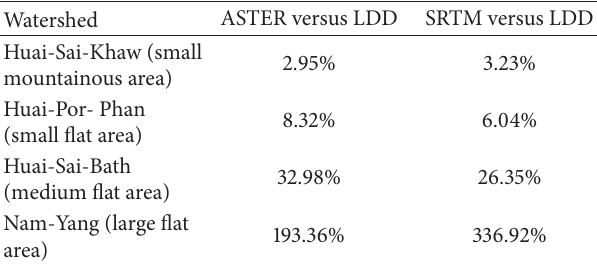
Table 13: Difference in stream slopes extracted from LDD DEM, ASTER DEM, and SRTM